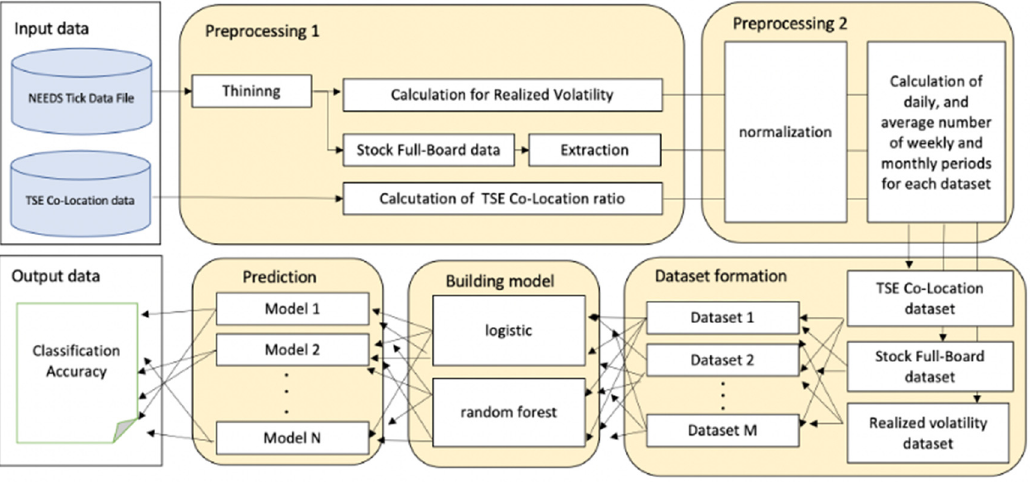
Figure 1. Overall process.